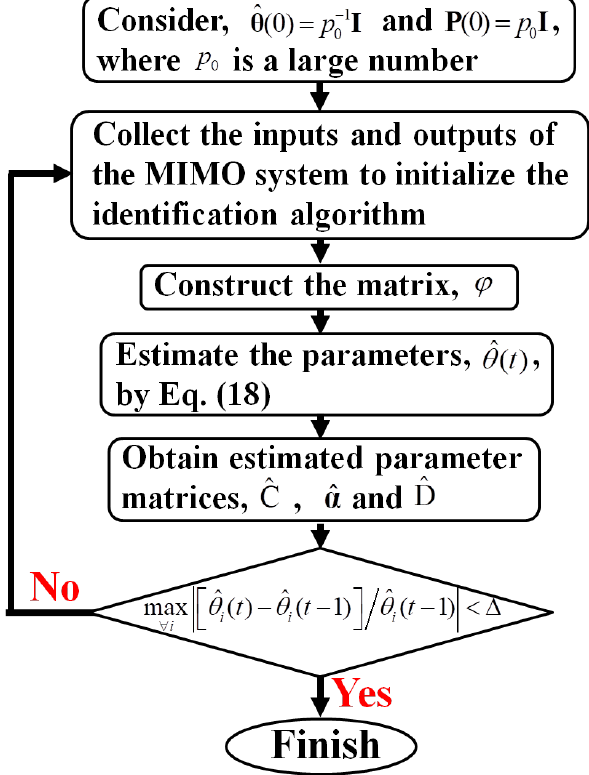
Figure 19. Flowchart of identification procedure of Wiener–Hammerstein model. The parameter ∆ shown in Equation (52) is set as